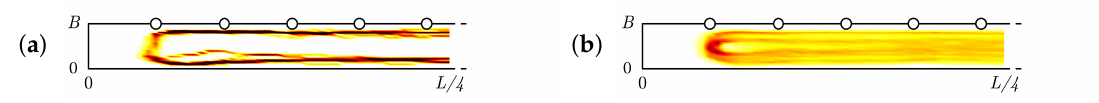
Figure 27. Heat map of the position for the case of walking for half a bridge deck during the test setup W148_free1: ( a ) a single pedestrian and ( b ) the entire